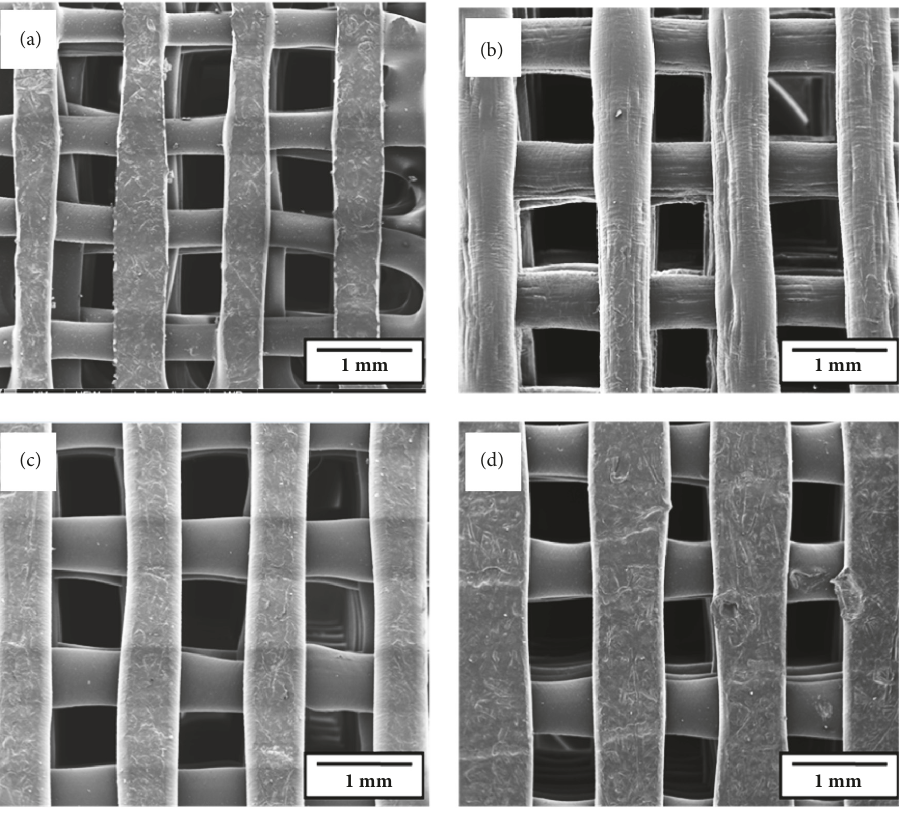
Figure 2: SEM images of the XY-plane top views of the fabricated scaffolds: (a) PCL; (b) PCL + 1 wt.% Biosilicate (cid:2) ; (c) PCL + 3wt.% Biosilicate (cid:2) ; and (d) PCL + 5wt.% Biosilicate (cid:2)